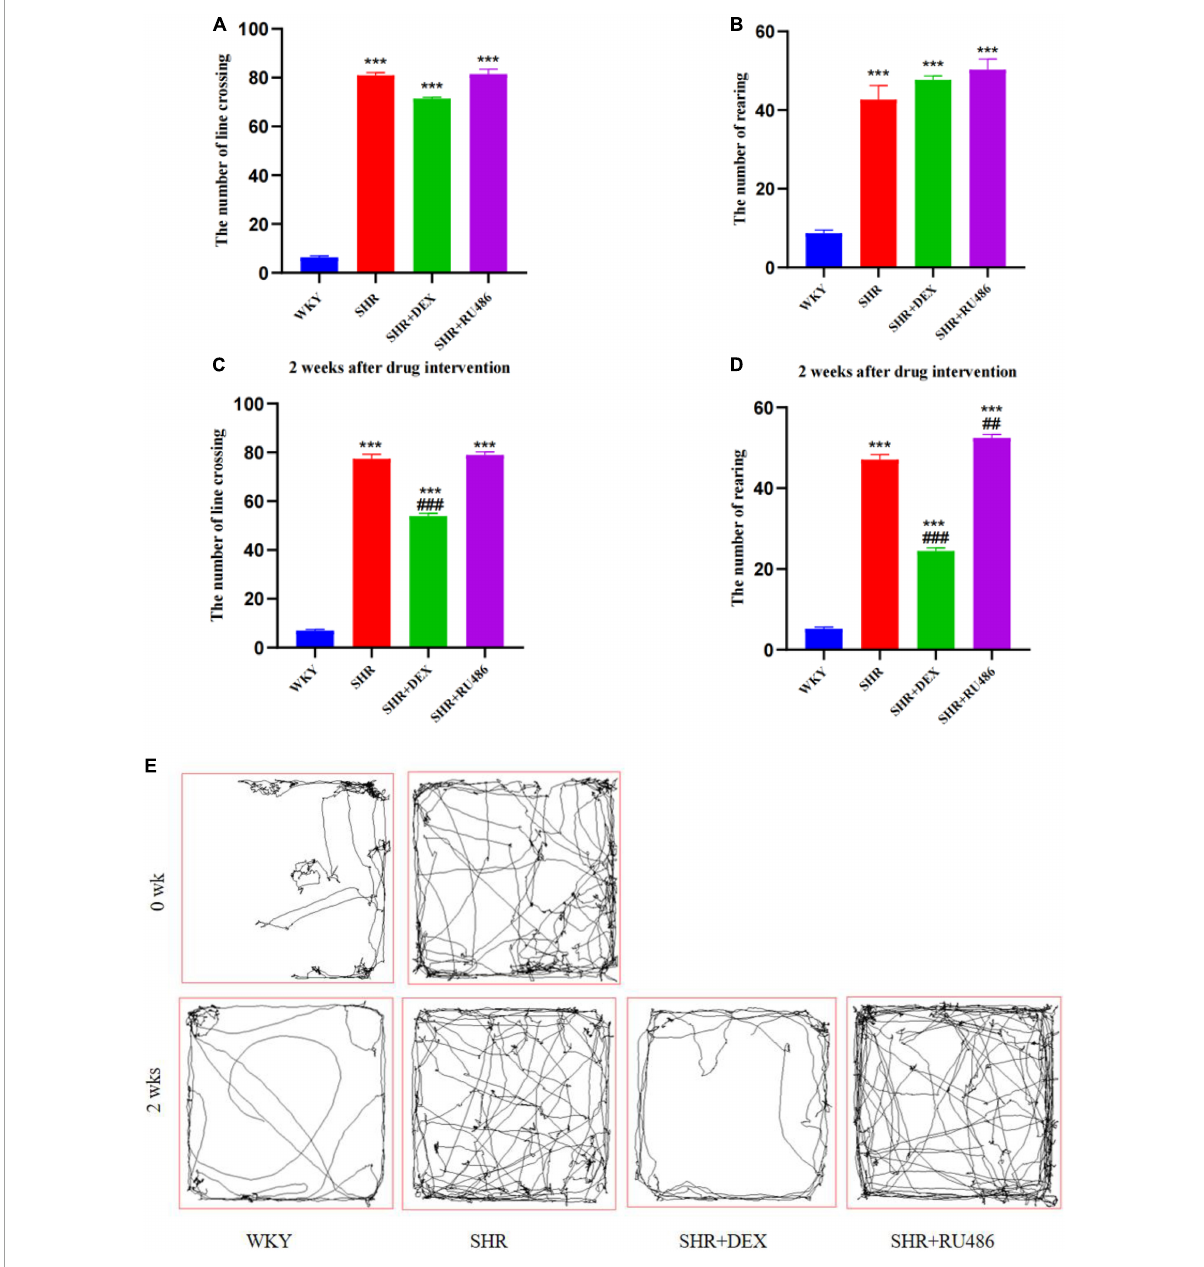
FIGURE2 Behavioral performance in open field test (OFT) ( n = 15 in each group). (A) The number of line crossings before drug intervention, (B) the number of rearing before drug intervention, (C) the number of line crossing after drug intervention for 2 weeks, (D) the number of rearing after drug intervention for 2 weeks, (E) representative pathways of each group before and after drug intervention. One-way analysis of variance (ANOVA) with repeated measures followed by post hoc with Tukey test. All data are presented as mean ± SEM. *** p < 0.001, compared to Wista Kyoto rats (WKY) group; ## p < 0.01, ### p < 0.001, compared to spontaneously hypertensive rats (SHR)